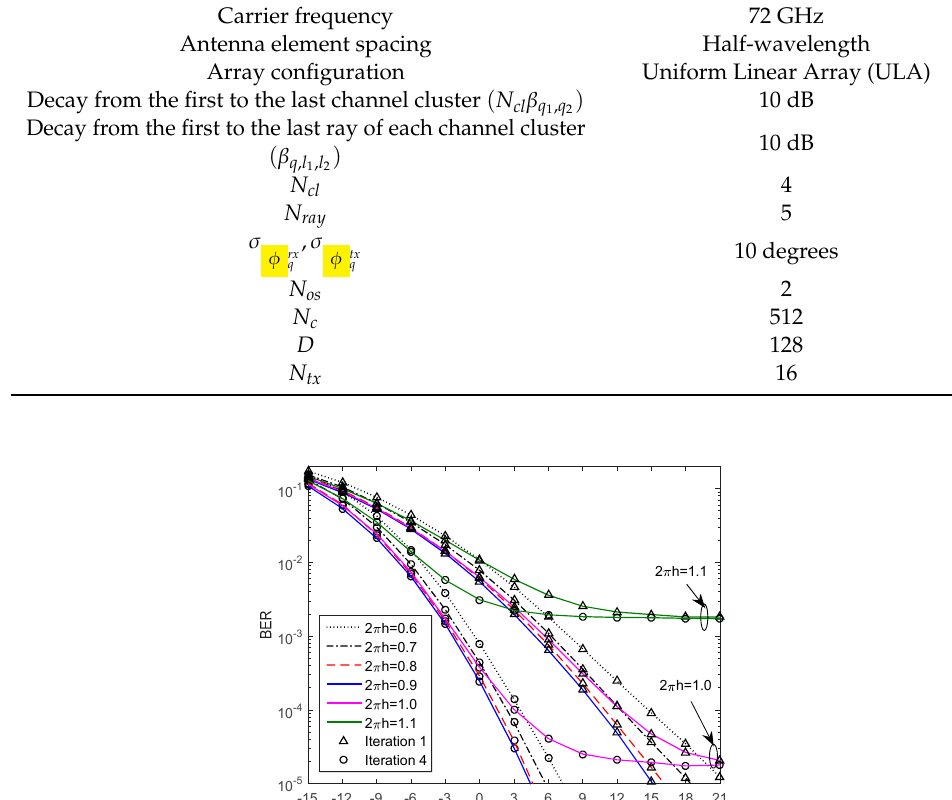
Table 1. Simulation parameters. Parameter Value Carrier frequency 72 GHz Antenna element spacing Half-wavelength Array configuration Uniform Linear Array (ULA)